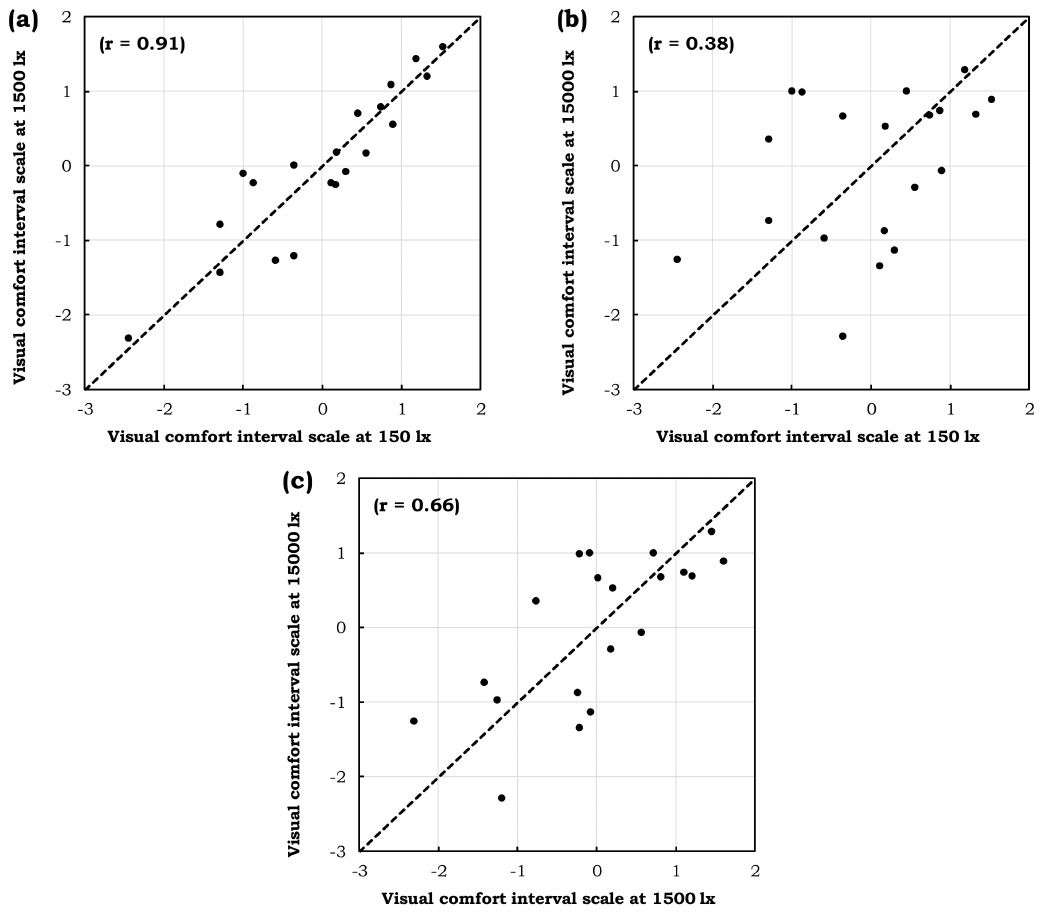
Figure 4. Correlation r between different ambient illuminance: ( a ) 150 lx vs. 1500 lx; ( b ) 150 lx vs. 1500 lx; ( c ) 1500 lx vs. 15,000